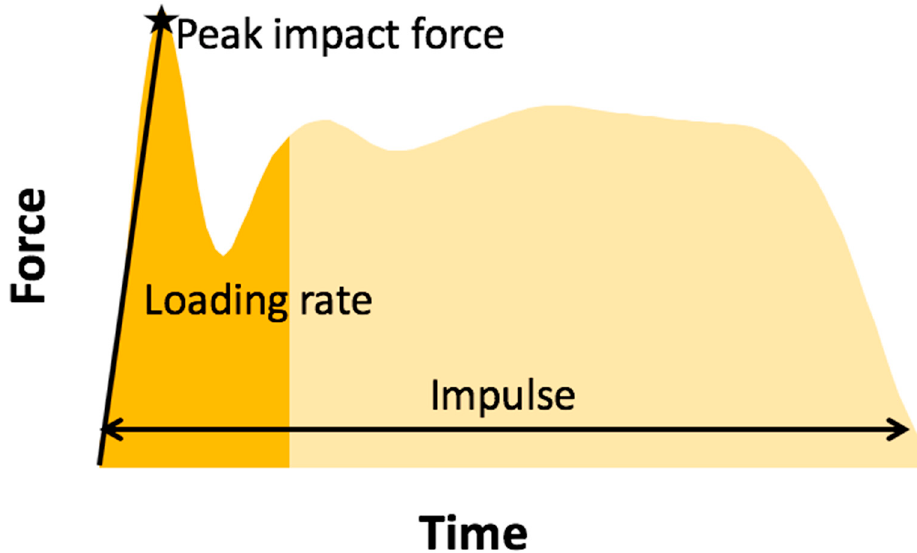
Figure 1. Example force–time data for one limb, collected during a stop jump trial.